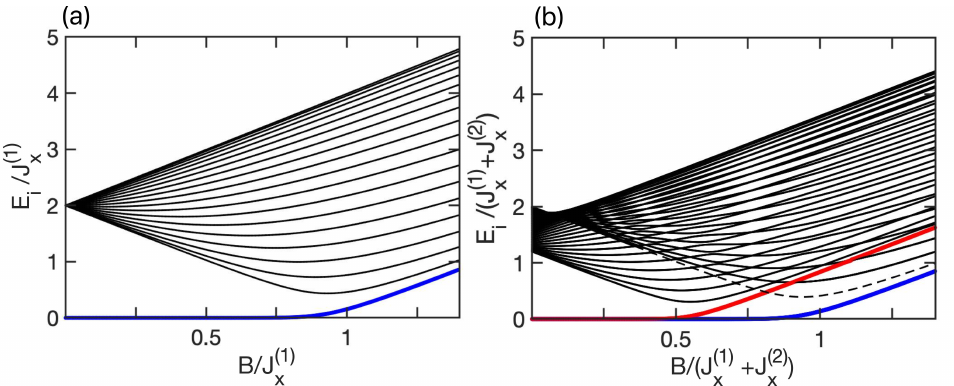
Figure 4: Single particle spectrum E transverse Ising model defined by J ( 1 ) extended model with parameters J ( 2 ) blue and red lines correspond to the two zero modes, with vanishing energy in the topological regime. The dotted line represents an effective, secondary gap E discussed in Sec.